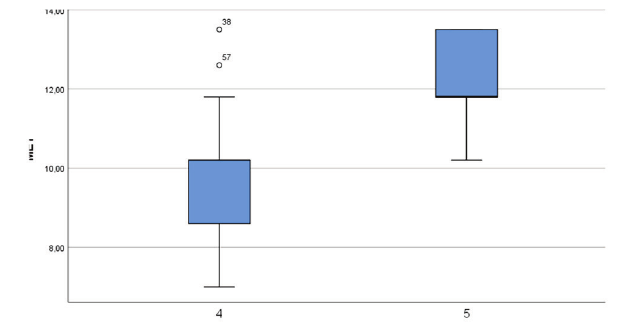
MET-Metabolic Equivalent; BMI-Body Mass Index; % FM-Percentage of Fat Mass; FFM- Free-Fat Comparison of Exercise Capacity (MET) by Quadriceps Femoris (QF) Strength